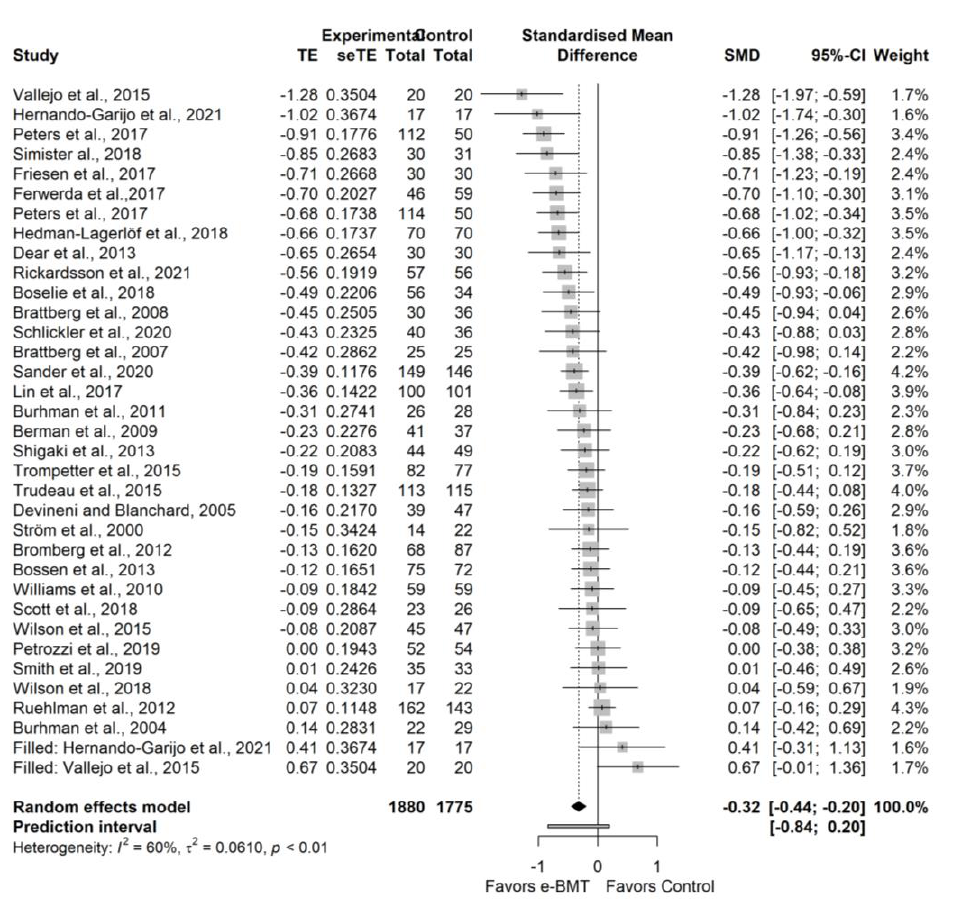
Figure A9. Contour-enhanced funnel plot of the studies included in the sensitivity analysis and the studies filled to adjust for publication bias.